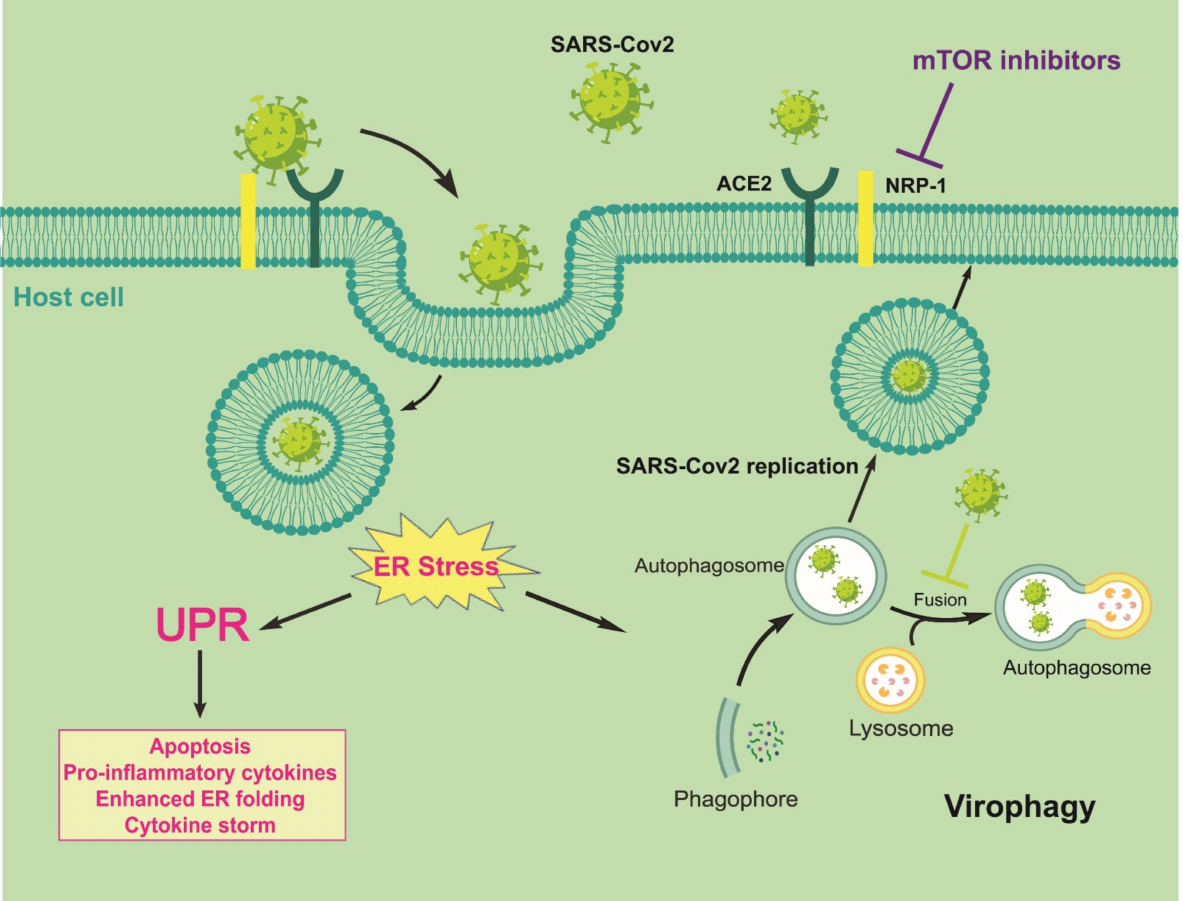
Figure 5. Possible cross-talk between virophagy (When the pathogen is a virus, degradation of viral components is called virophagy, which is one type of selective autophagy), UPR, and neuropilin-1 in SARS-CoV-2